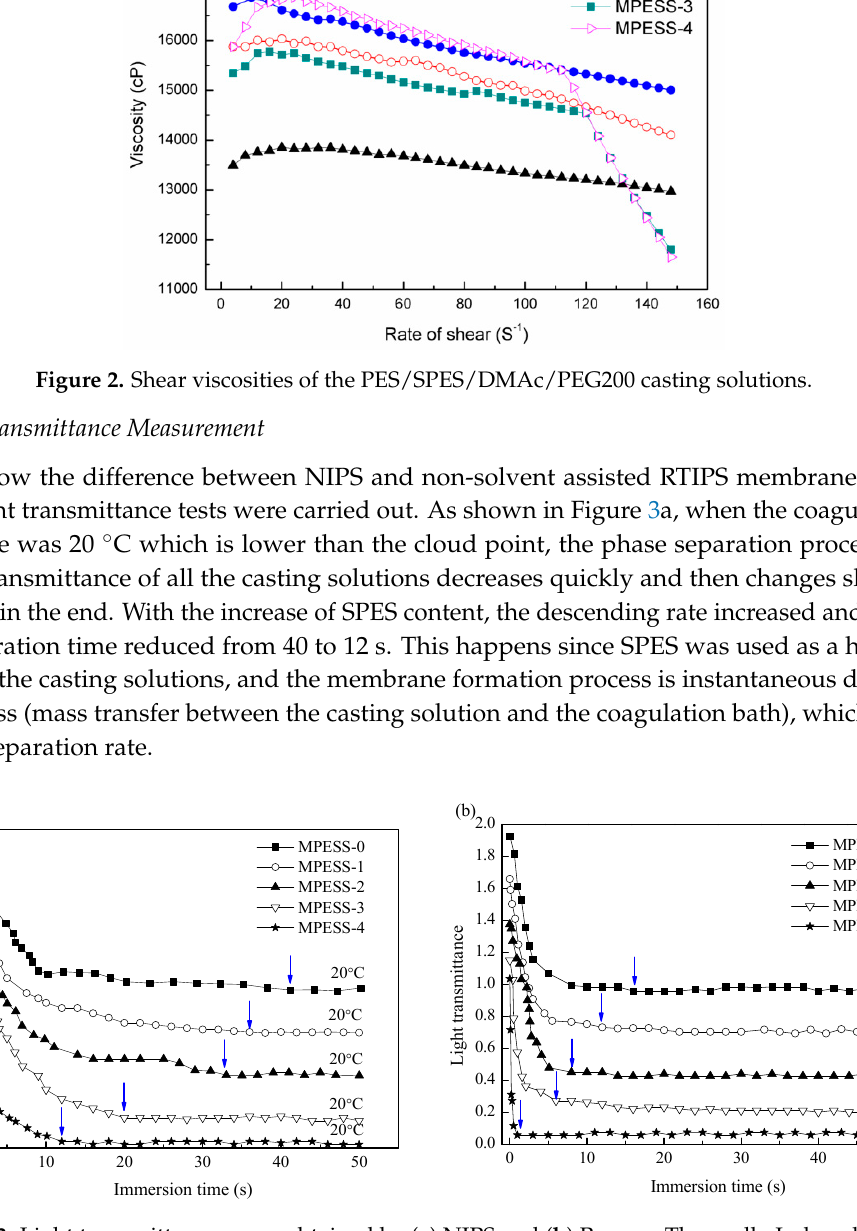
Figure 3. Light transmittance curve obtained by ( a ) NIPS and ( b ) Reverse Thermally Induced Phase Separation (RTIPS) mechanism. (Profiles are shifted for the purpose of clarity). 3.4. Membrane Morphology